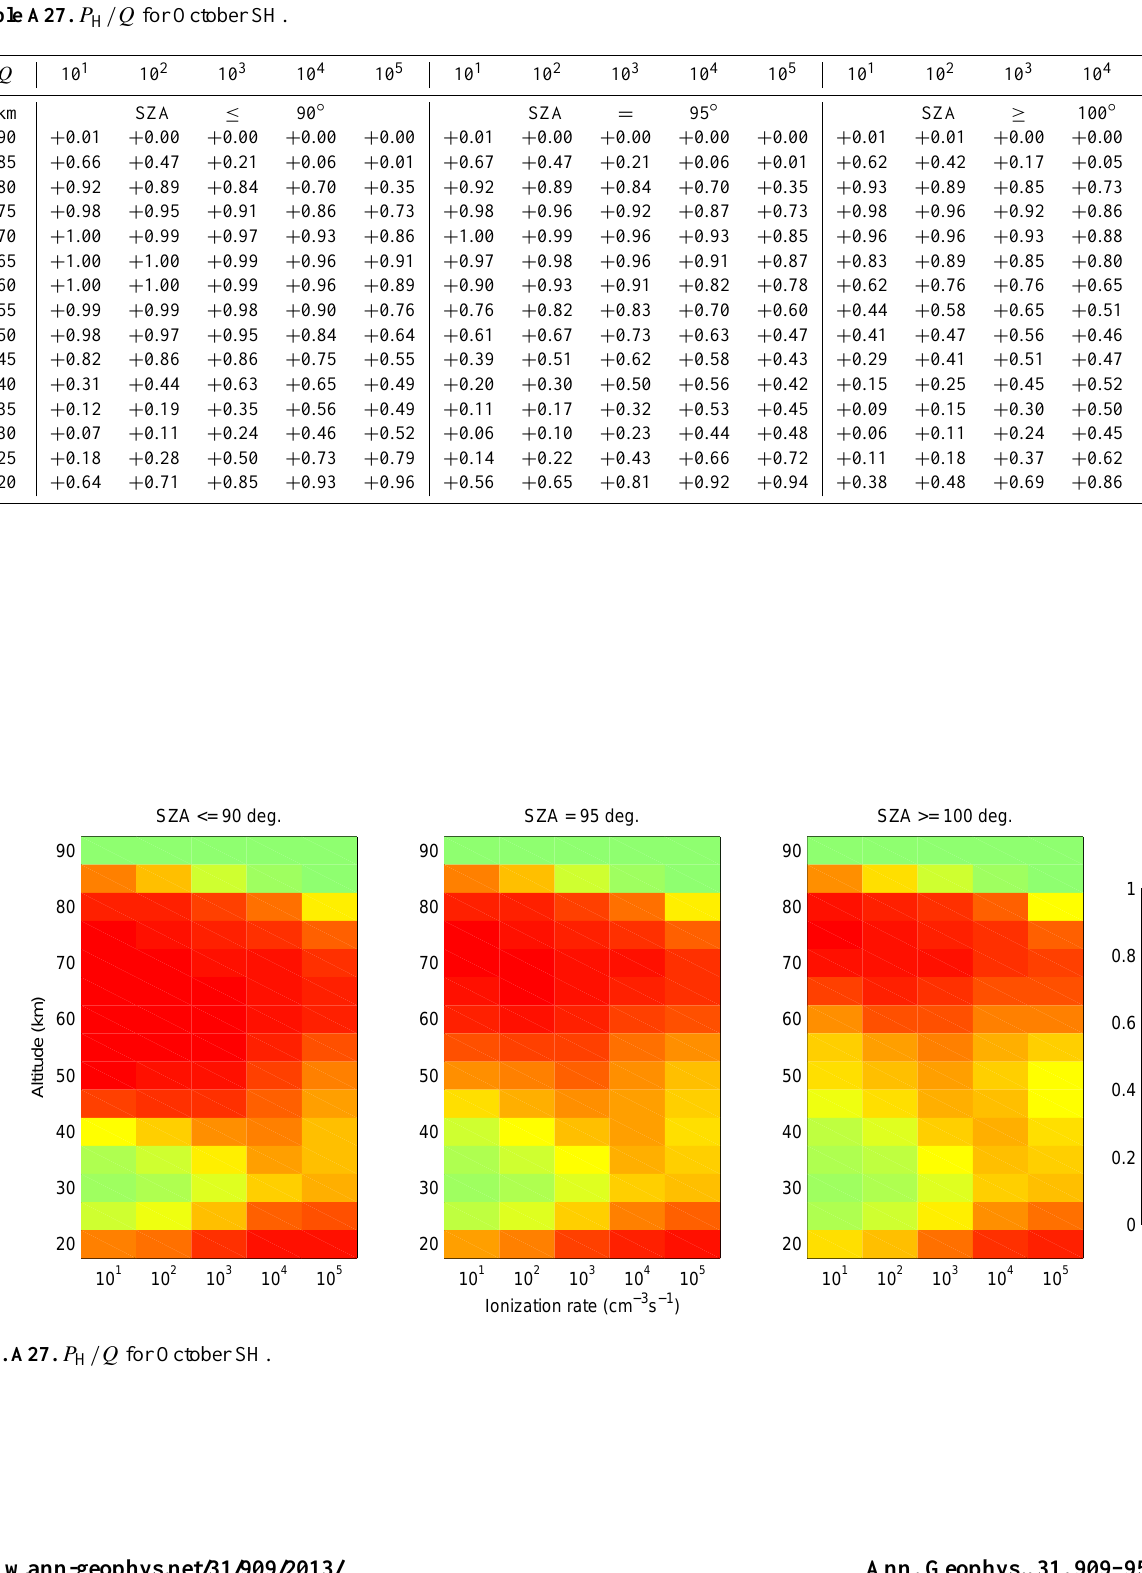
Table A27. P H /Q for October SH.